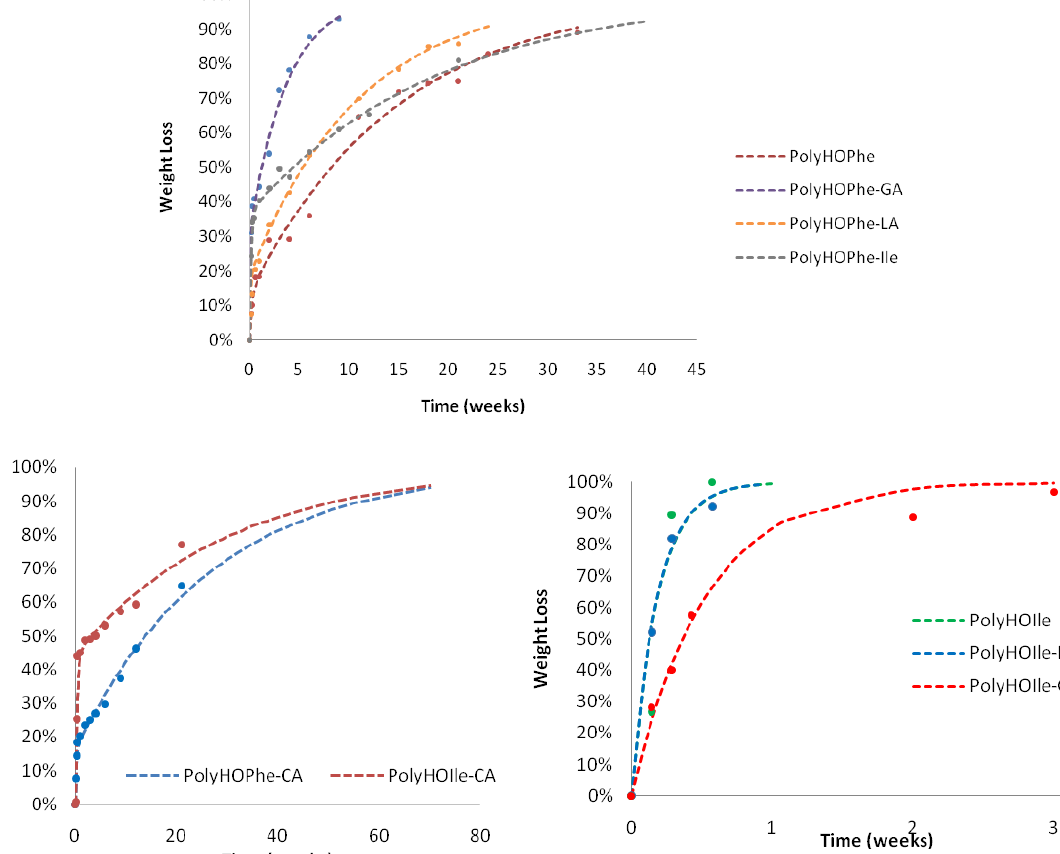
Figure 3 . Hydrolysis of copolymers of HOPhe and copolymers of HOIle monitored by weight loss. The broken curves correspond to the theoretical rates whereas the points are the experimental